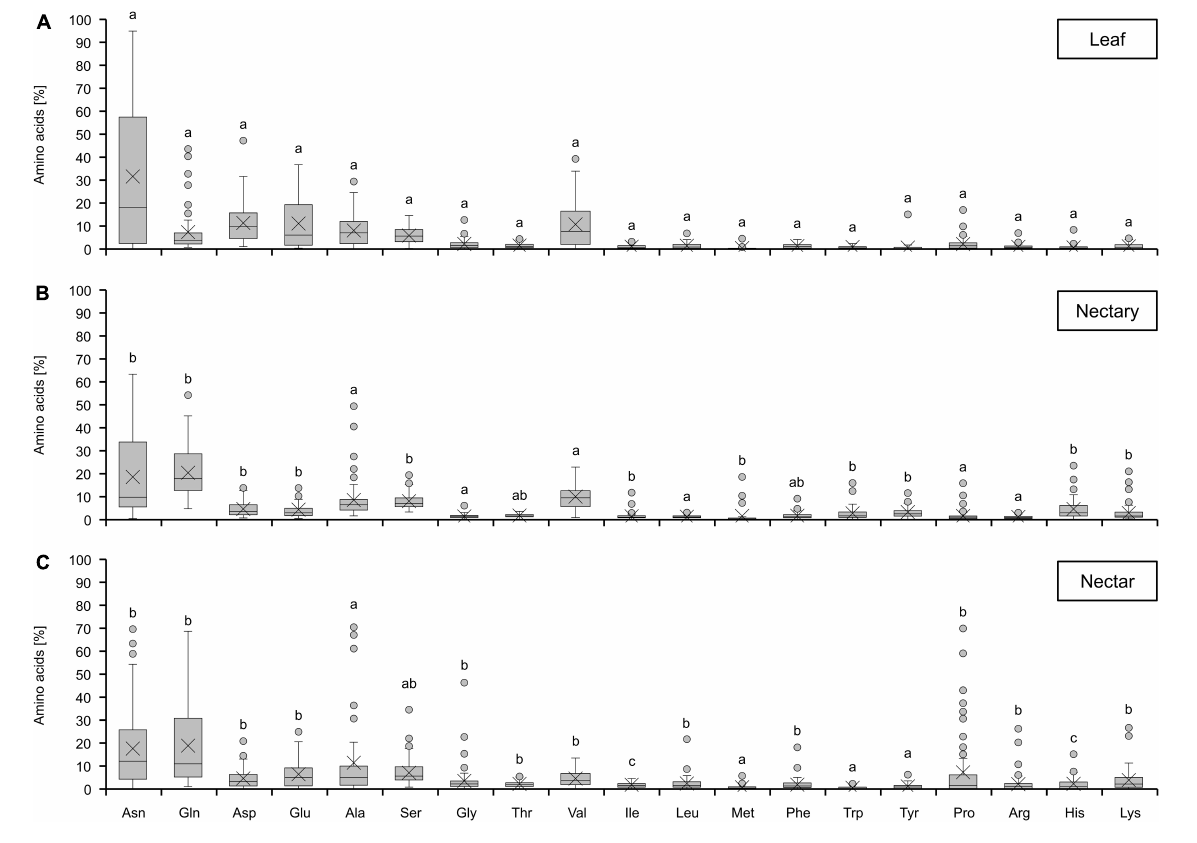
FIGURE3 Percentage of different amino acids in leaf (A) , nectary (B) and nectar (C) . The shown data includes all 36 bromeliad species ( n = 3). Different letters represent significant differences in individual amino acids between leaf, nectary and nectar (Tukey’s HSD; p <